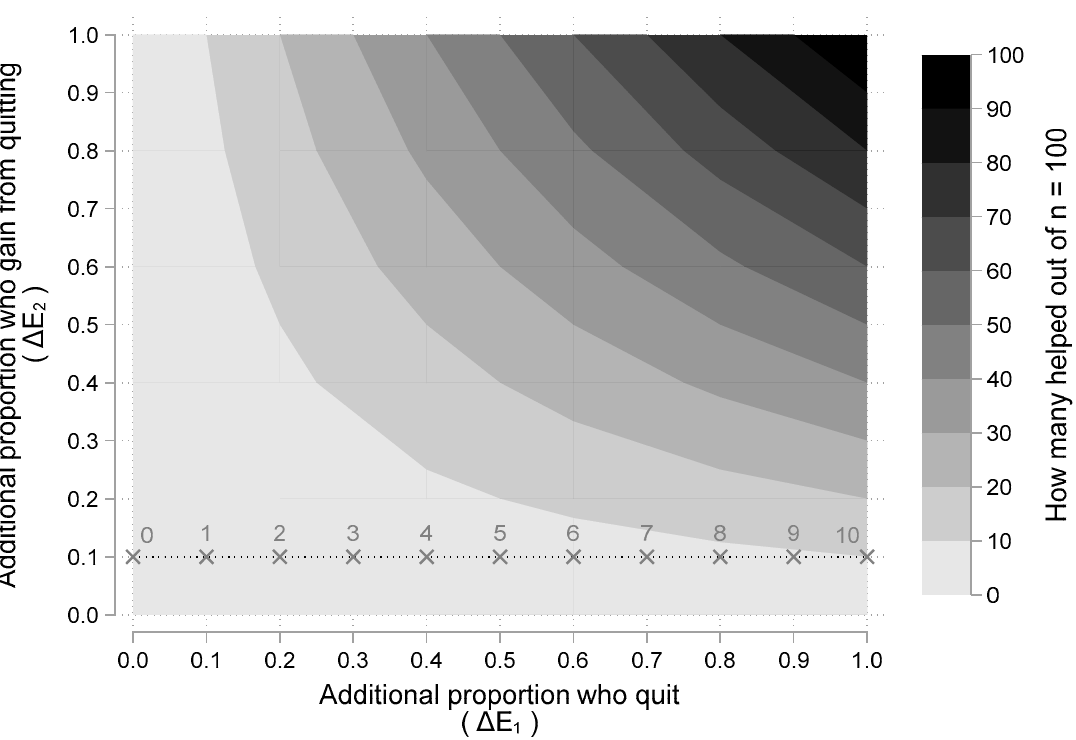
Figure 2. How many people from a population of n = 100 are helped by a smoking cessation program as a function or the proportion who quit and the proportion who benefit from quitting. Note: Figure 2 illustrates a “two-way” sensitivity analysis illustrating the impact of different assumptions about the two main “chance” events: (1) additional proportion of people who quit (i.e., ∆ E 1 ); and (2) additional proportion who gain better outcomes from quitting (i.e., ∆ E 2 ). The shaded area indicates how many people will benefit out of a hypothetical population of 100 given assumed values for ∆ E1 and Δ E 2 . At Δ E 2 = 10%, 10% increases in Δ E 1 increases the number of people helped by one (as indicated by the labels over the points marked with an ×. At Δ E 2 = 100%, 10% increases in Δ E1 increases the number of people helped by ten (as indicated by the shaded regions).